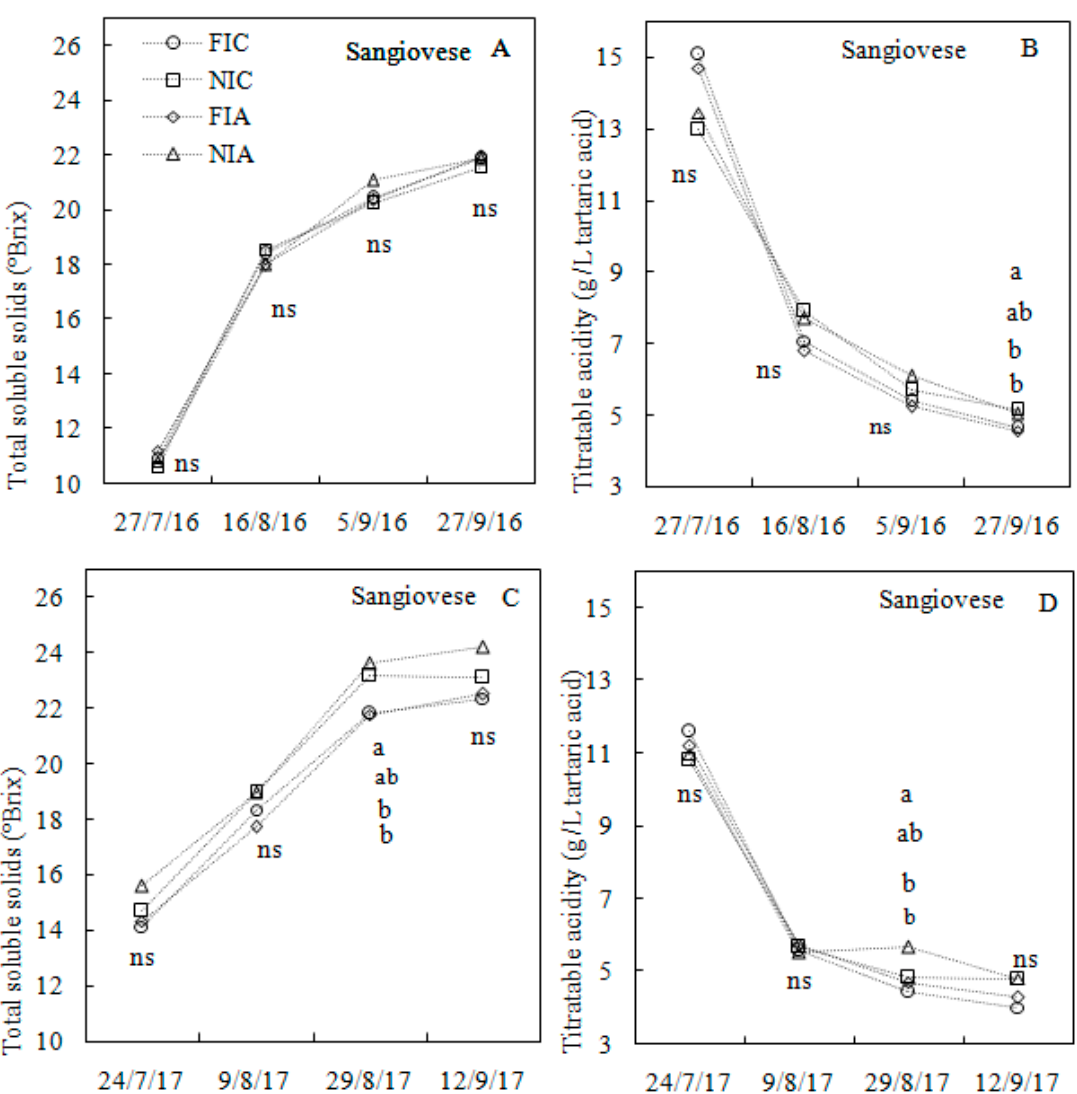
Figure 4. Seasonal variations of grape total soluble solids in 20016 ( A ) and 2017 ( C ) and titratable acidity in 2016 ( B ) and 2017 ( D ) cv. ‘Sangiovese’. FIA = full irrigation ( + ) ABA; FIC = full irrigation ( − ) ABA; NIA = no irrigation ( + ) ABA; NIC = no irrigation ( − ) ABA. The di ff erent letters indicate statistical significance at P ≤ 0.05 using the LSD test. ns = not significant.